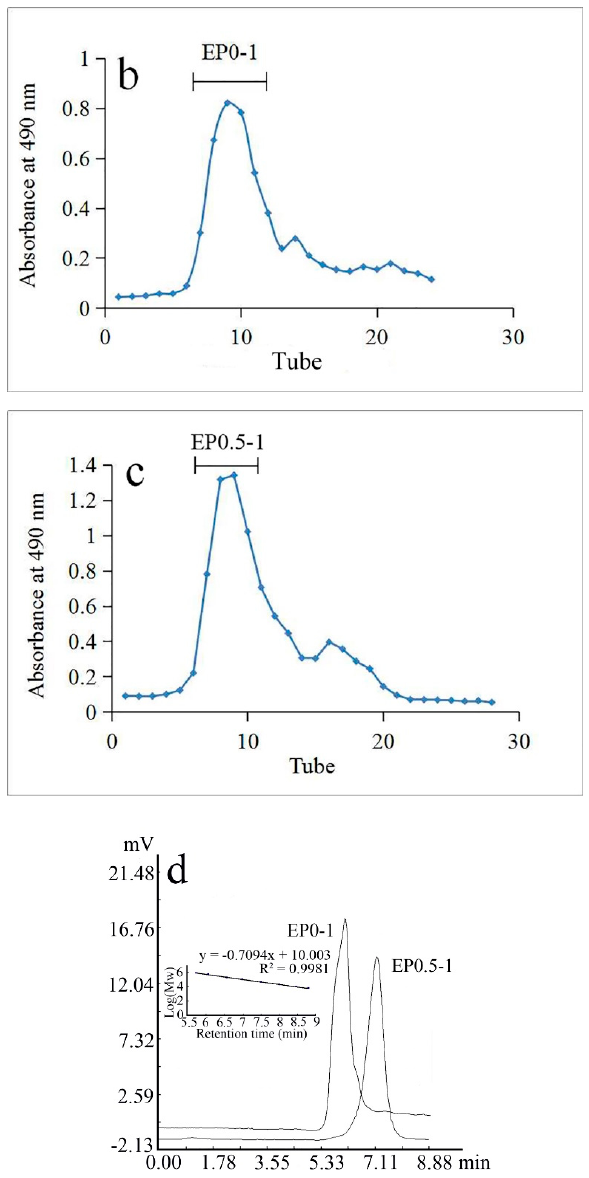
Figure 1. Isolation and HPGPC chromatogram of the polysaccharides produced by Exobasidium gracile . ( a ) The crude polysaccharides were fractionated by anion exchange chromatography through a Q Sepharose Fast Flow column and isolated to two fraction EP0 and EP0.5. ( b ) The major fractions eluted by water and 0.5 mol / L NaCl were further purified on a Sephacryl S-200 column and isolated a fraction EP0-1. ( c ) The major fractions eluted by water and 0.5 mol / L NaCl were further purified on a Sephacryl S-200 column and isolated a fraction EP0.5-1. ( d ) The purity and molecular weights of EP0-1 and EP0.5-1 were studied using HPGPC.